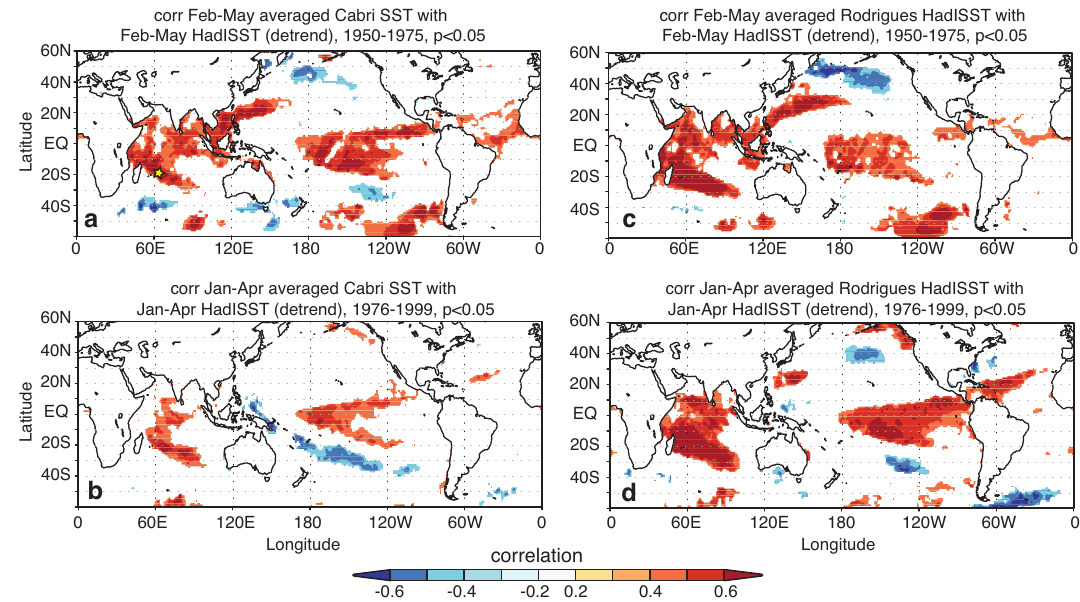
Figure 7. Spatial correlations of Cabri coral SST (left) and HadISST grid for Rodrigues Island with global austral summer HadISST (right) for (a–c) 1950 to 1975 (February to May) negative PDO phase (Mantua et al., 1997) and (c–d) 1976 to 1999 (January to April) positive PDO phase. Only correlations with p <0.05 are coloured. Computed at KNMI Climate Explorer (van Oldenborgh and Burgers, 2005). Yellow star in (a) marks location of Rodrigues Island.